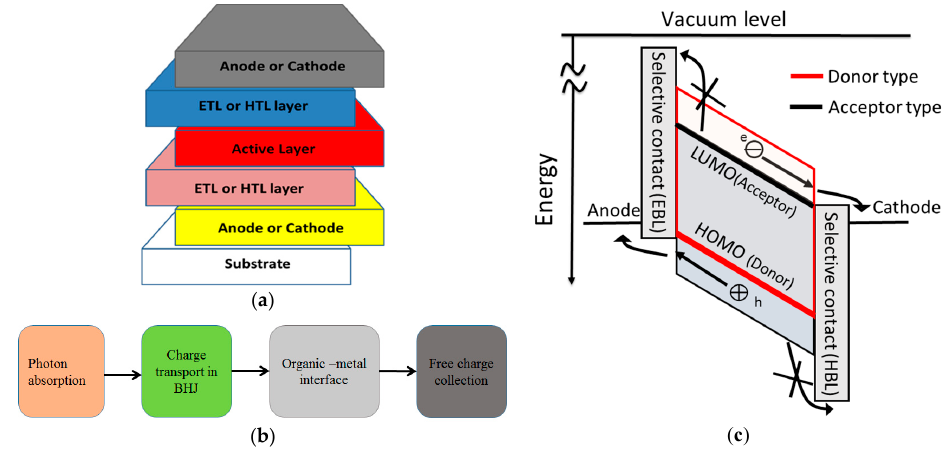
Figure 1. Schematic diagram of ( a ) multilayer structure; ( b ) primary developed model; and ( c ) band diagram representation of organic solar cell (OSCs). ETL: electron transport layer; HTL: hole transport layer; BHJ: bulk heterojunction; LUMO: lowest unoccupied molecular orbital; HOMO: highest occupied molecular orbital; EBL: electron blocking layer; and HBL: hole blocking layer.